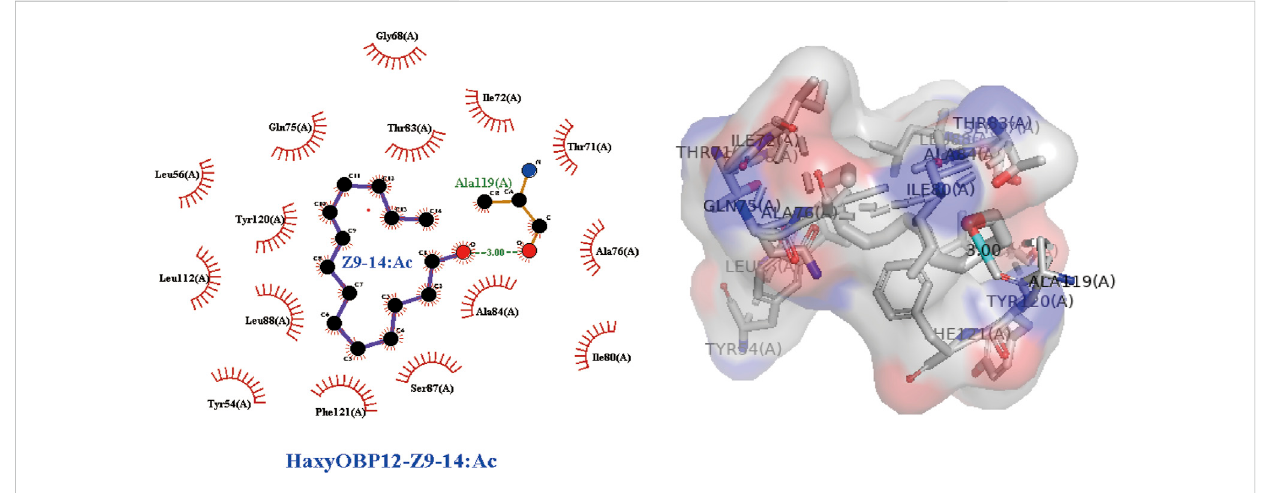
FIGURE 6 Interactions between HaxyOBP12 protein and